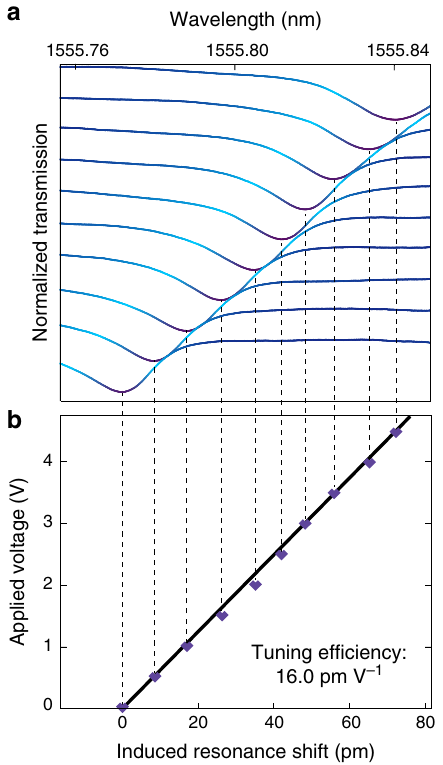
Fig. 5 Electro-optic tuning property of an LN photonic-crystal EOM. a Recorded transmission spectrum of the EOM cavity as a function of applied DC voltage from 0 to 4.5 V, with a voltage step of 0.5 V. b Recorded resonance shift as a function of applied DC voltage, where the experimental data are shown in black dots and the blue line is a linear fi tting to the